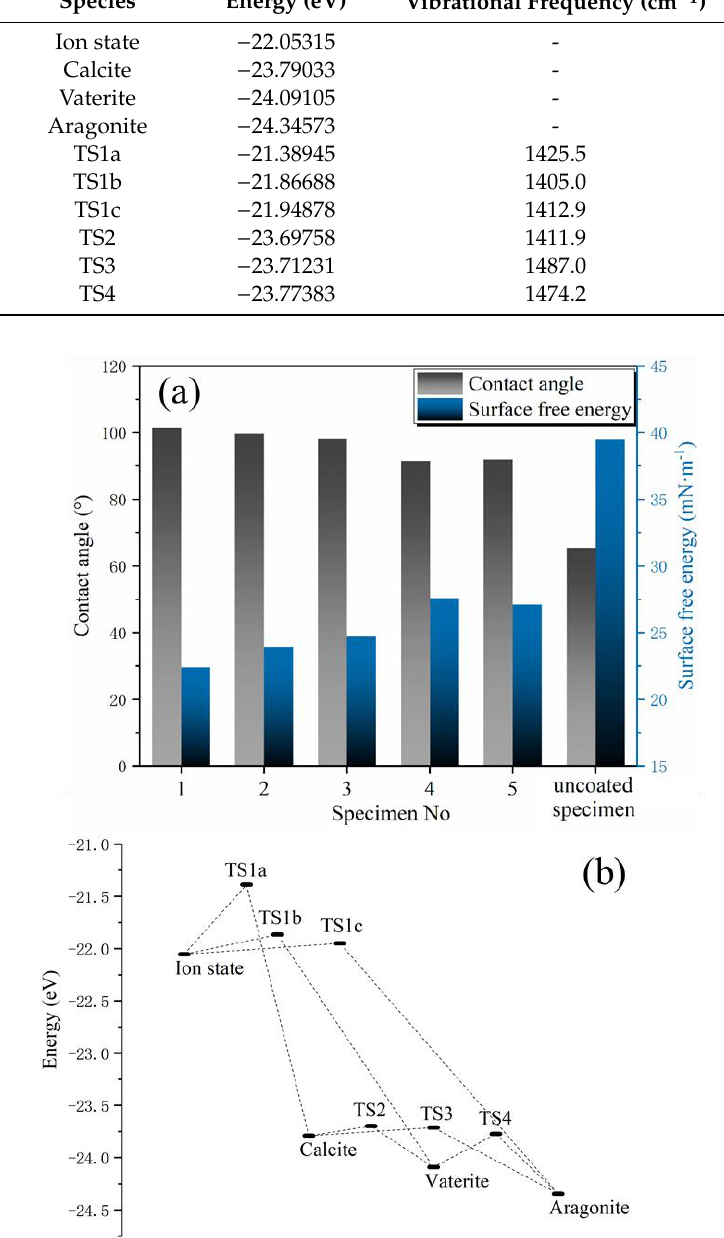
Figure 12. ( a ) Contact angle and surface energy of uncoated specimen and the Ni-W-P coatings; ( b ) Energetic profile for potential energy surface of calcite, vaterite, and aragonite.